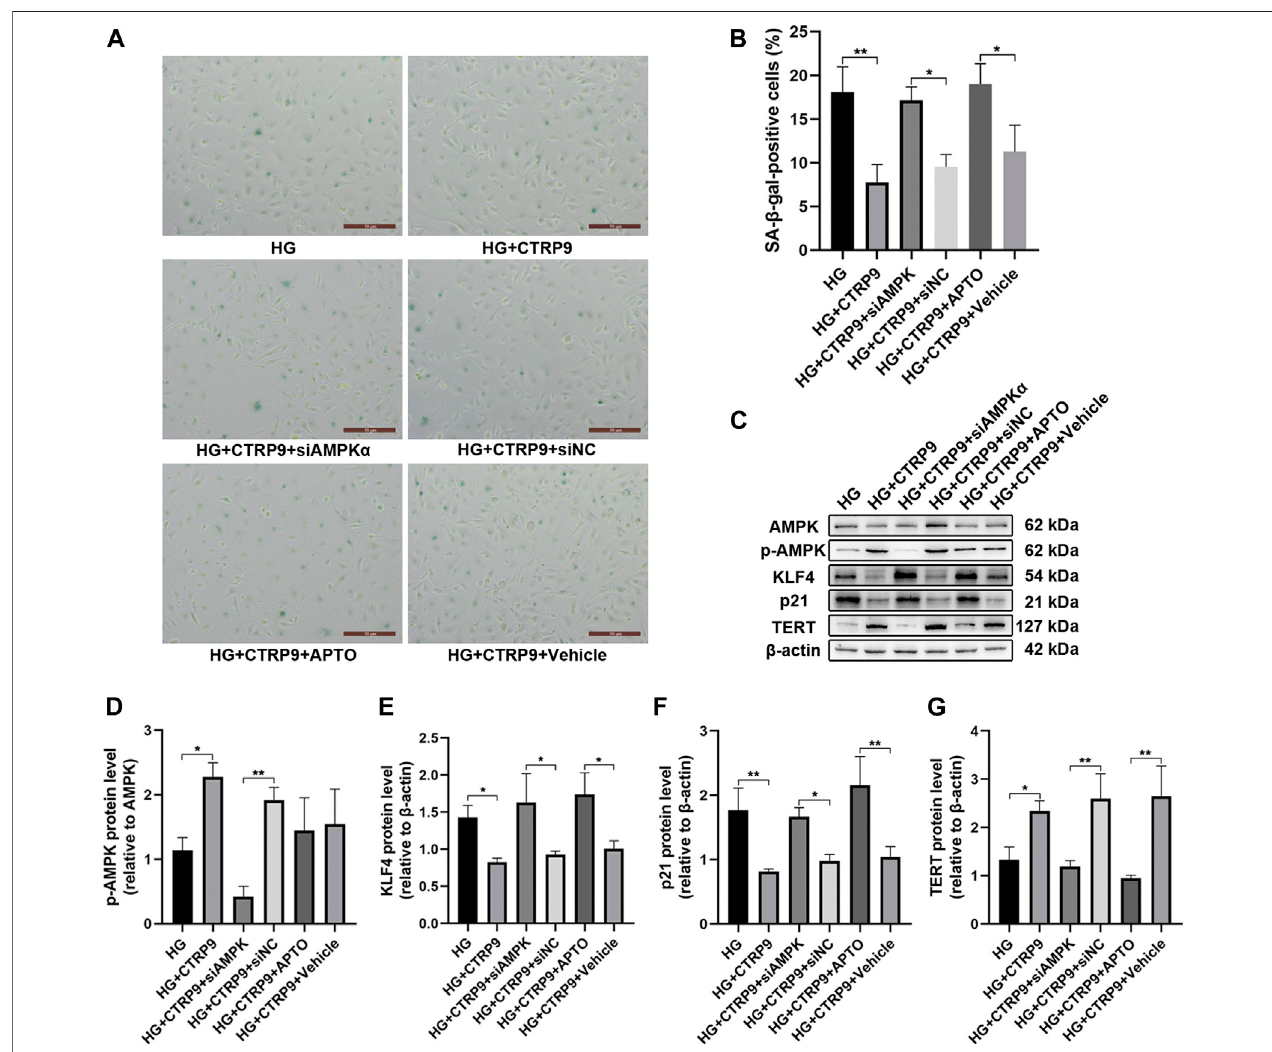
FIGURE5| CTRP9-mediated anti-senescence effect ismediated via the AMPK α /KLF4 pathway. (A) Cells were fi xed and stained forSA- β -gal activity. The images were taken at × 10magni fi cation. (B) The histogram represents the quantitative analysis of SA- β -gal-positive cells per microscopic fi eld. Values represent mean ± SEM. * p < 0.05, ** p < 0.01. (C) AMPK, p-AMPK, KLF4, p21 and TERT protein levels were determined by immunoblotting. (D-G) Results were normalized to controls, and histograms represent the relative intensities of p-AMPK, KLF4, p21, and TERT. Values represent mean ± SEM ( n (cid:2) 3 – 4 per group). *p < 0.05, **p < 0.01.